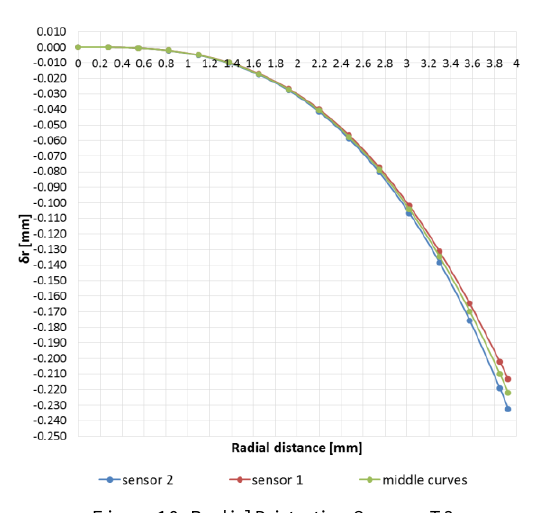
Figure 9 Radial Distortion Curves- T2